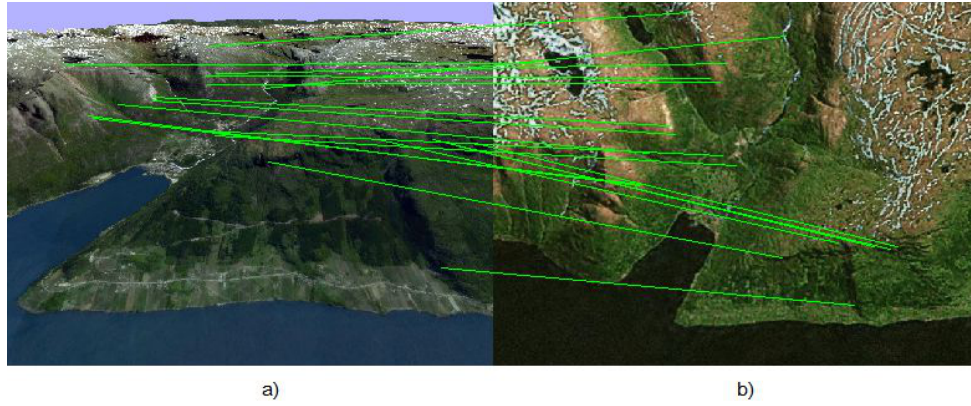
Figure 5. Correspondence between ( a ) (image I c of the on-board camera of the UAV) and ( b ) (template image loaded in the UAV memory in advance) feature points found with the aid of RANSAC based on the UAV motion model. The number of outliers reduces substantially.